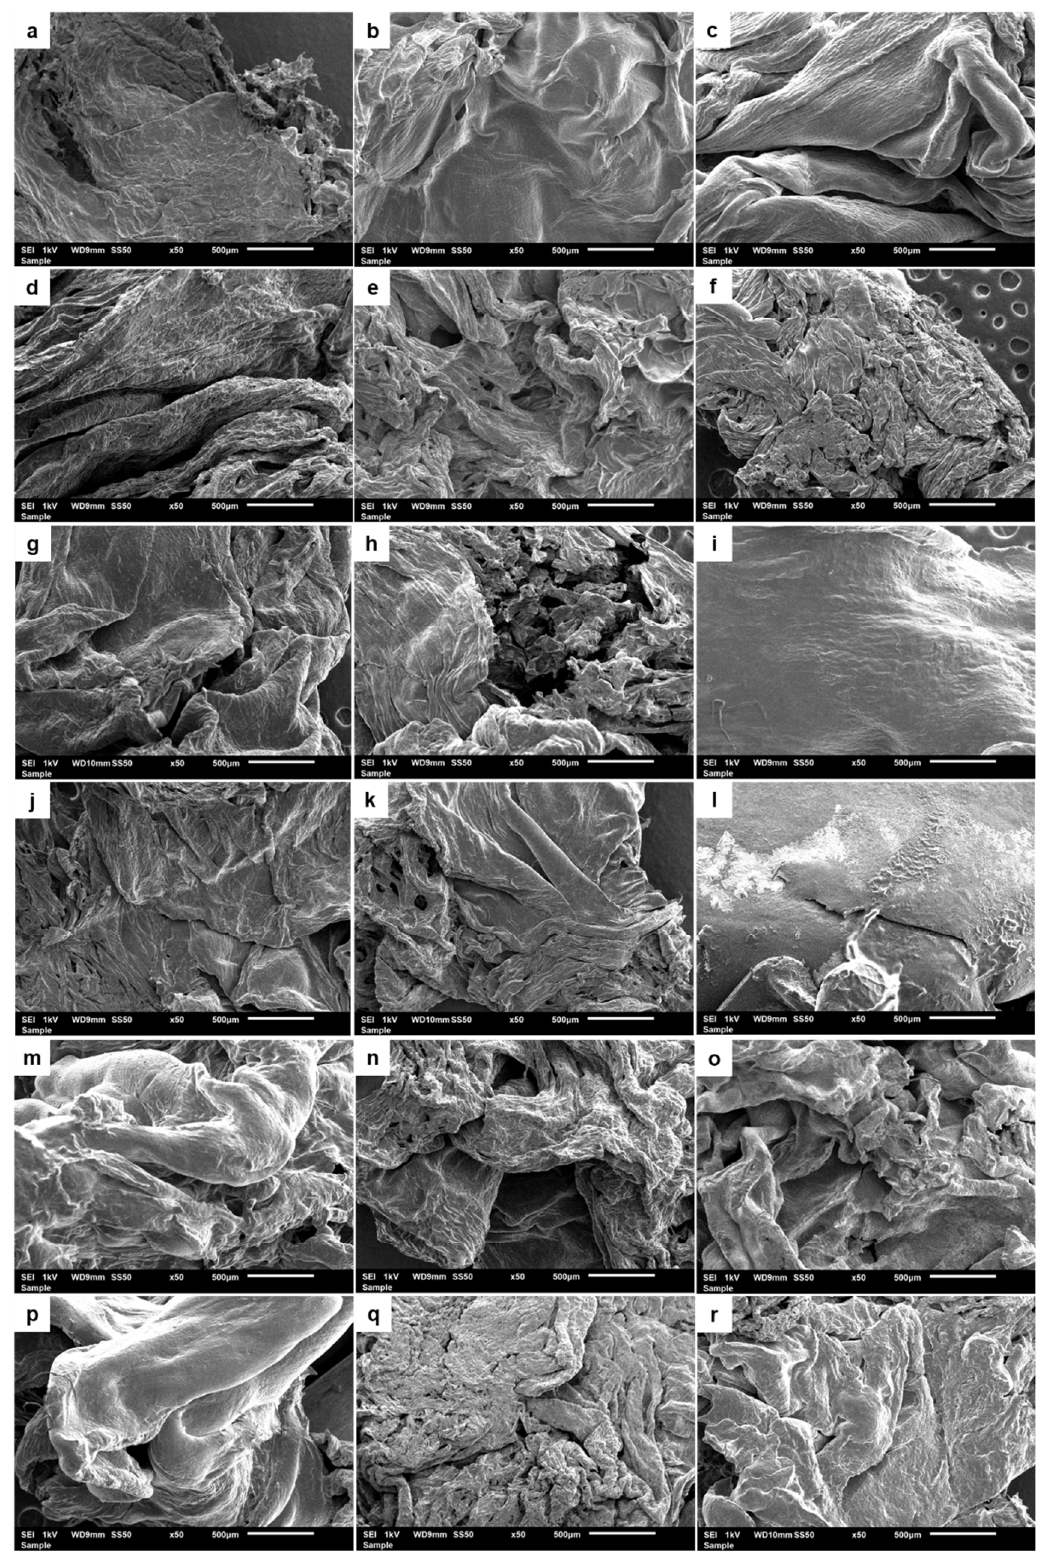
Figure 5. Scanning electron microscopy images of the control, HEC100, HEC1000, CMC100, CMC1000, Chit100, Chit1000, GA100 and GA1000 media at the beginning ( a , b,c , g , h , i , m , n and o , respectively) and at the end ( d , e , f , j , k , l , p , q and r , respectively) of the eight-week culture period. The scale bars represent 500 μ m. Magnification: 50 × . CMC: carboxymethylcellulose sodium salt; Chit: chitosan; GA: gum arabic; HEC: hydroxyethyl cellulose; 100: 100 mg L − 1 ; 1000: 1000 mg L − 1 .